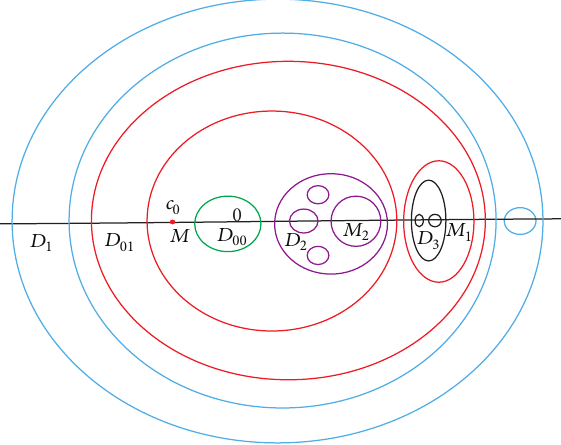
Figure 3: Schematic diagram of ∪ 2 𝑖=0 𝑅 −𝑖 (𝐷 00 )